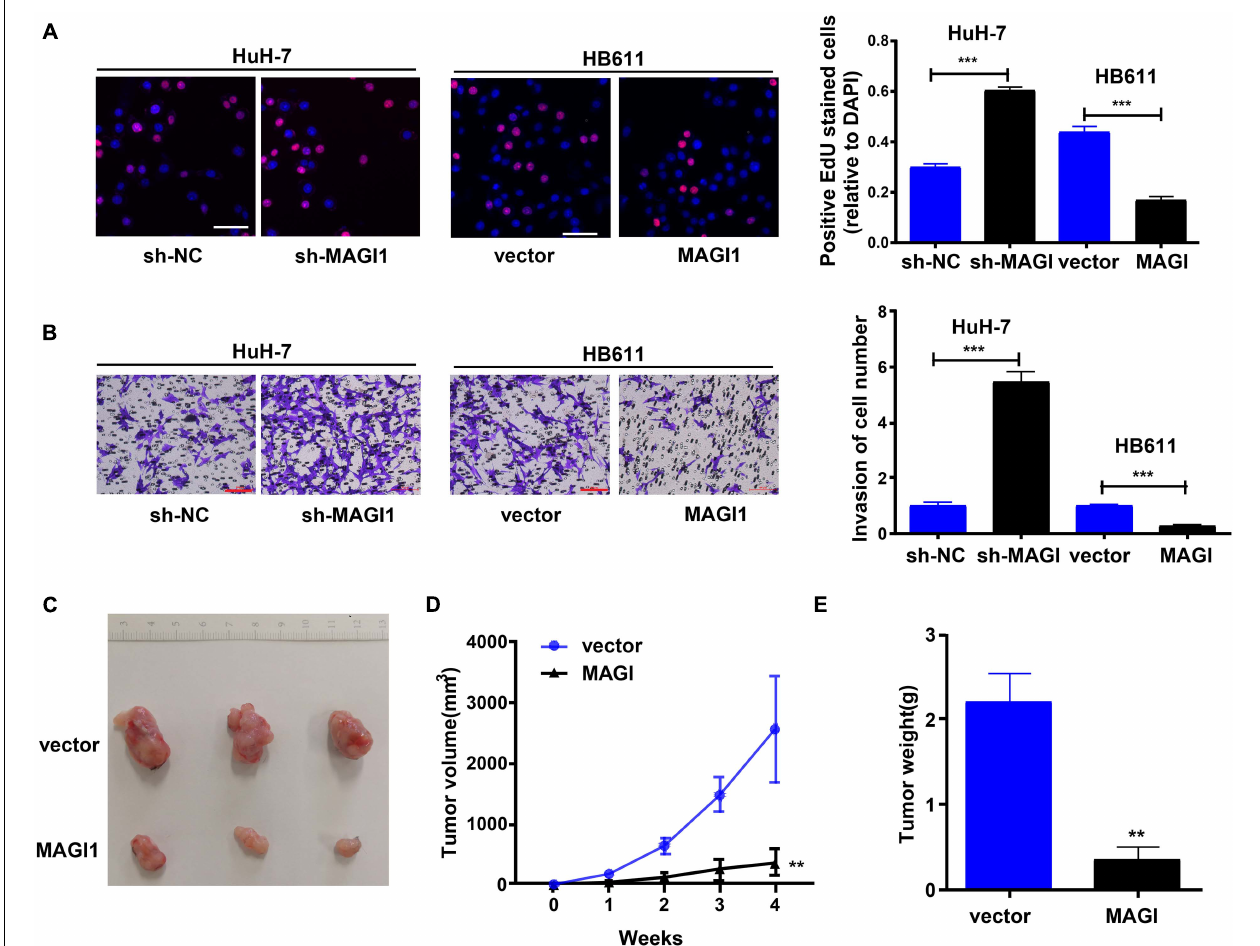
FIGURE 6 | MAGI1 inhibited the proliferation, invasion, and tumor formation of HCC. (A) Cell viability was analyzed by EdU assay (bar = 50 µ m). (B) Transwell assays were used to determine the invasion of HCC cells (bar = 100 µ m). (C) Representative image of tumors formed in nude mice from empty vector and MAGI1 overexpression vector groups. (D) Tumor volume and (E) weight data of indicated orthotopic xenografts. ** P < 0.01, *** P <